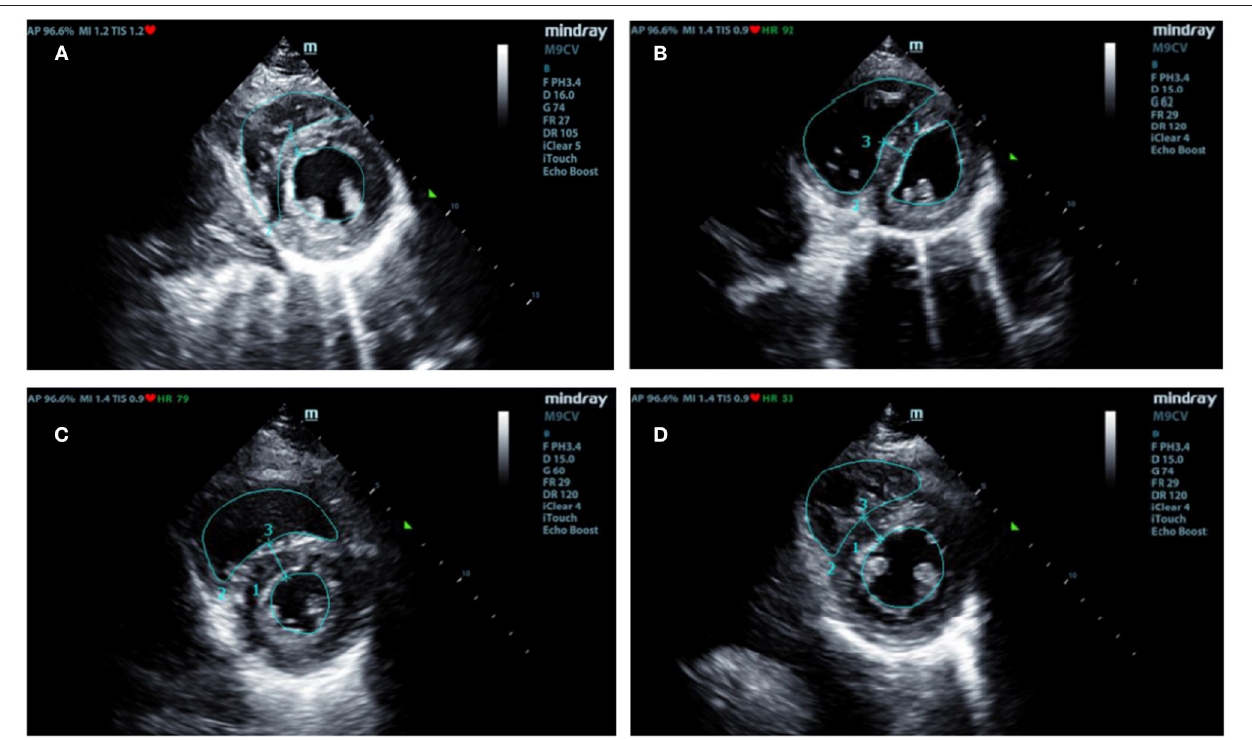
FIGURE 4 | Typical changes of cardiac morphology during various durations of exposure to high altitude. End-systolic short-axis images. (A) Han lowlanders (controls) with normal volume and thickness. (B) Short-term Hans migrants ( < 1 year) had enlarged RV with the leftward shifted interventricular septum. (C) Long-term Hans migrants ( > 5 years) had significantly thickened LV wall with recovered RV size. (D) Native Tibetans had no or minimal differences in LV structure compared with Han lowlanders. RV, right ventricular; LV, left